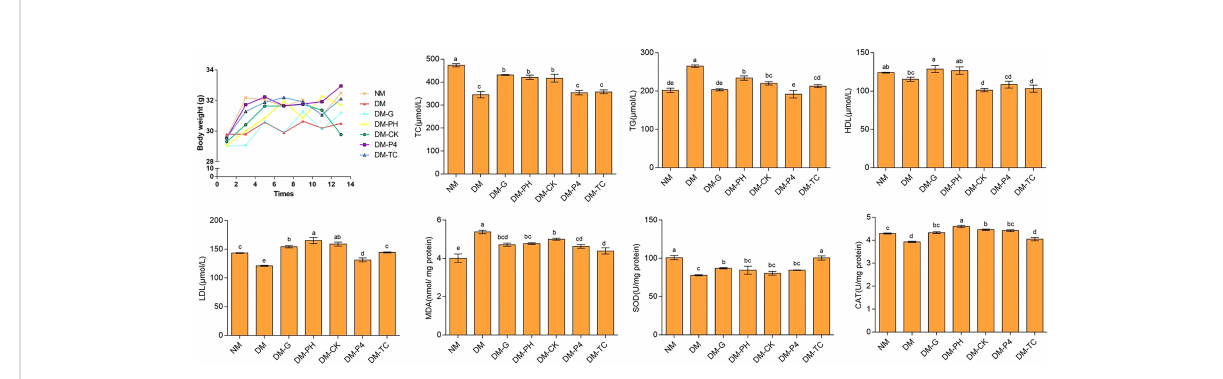
FIGURE 5 Body weight and serum biochemical indexes of mice under different treatments. Different letters in columns indicate signi fi cant difference determined by Tukey ’ s test ( p < 0.05; n =